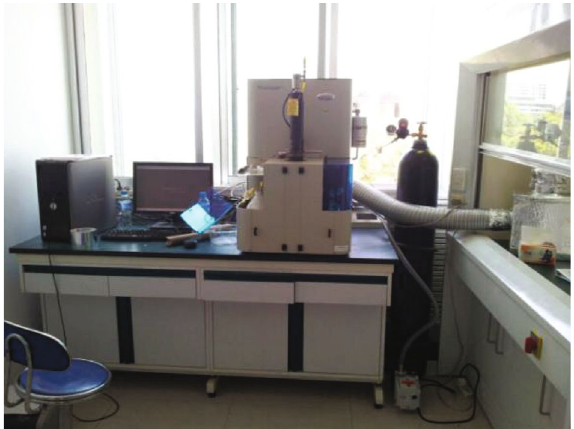
Figure 3: Constant speed mercury injection